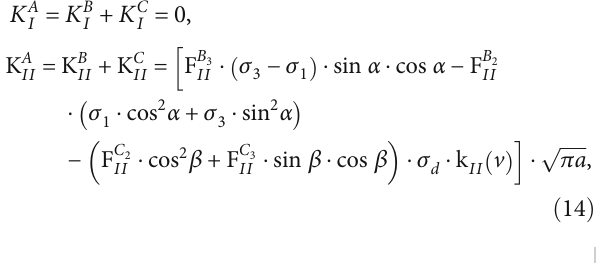
Table 1: Calculation results of f